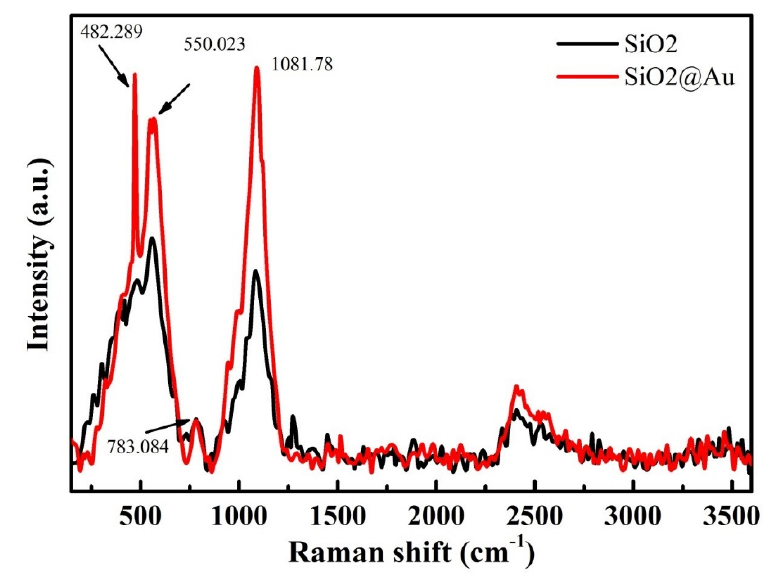
Figure 8. Raman spectra of methylene blue solution deposited on SiO 2 and SiO 2 @Au.